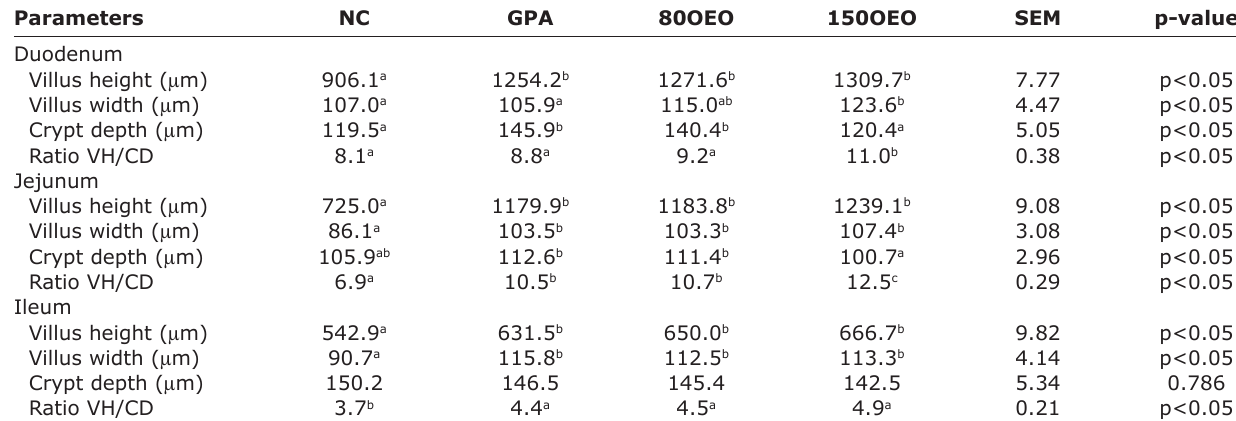
Table-4: Effect of the inclusion of oregano essential oil on the morphometry of the small intestine in Isa Brown hens.